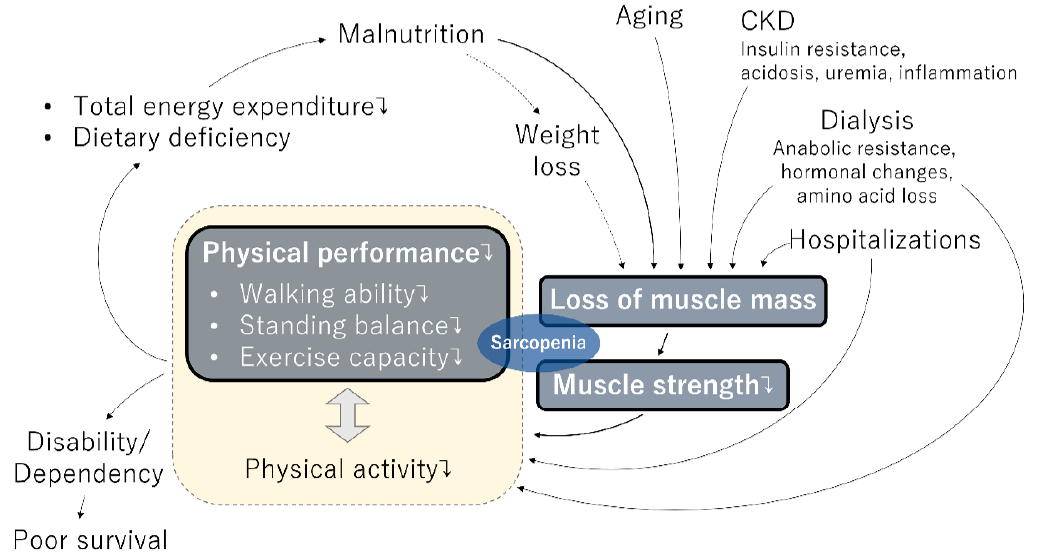
Figure 1. Cycle of frailty in patients with chronic kidney disease (CKD), adapted from Matsuzawa et al.